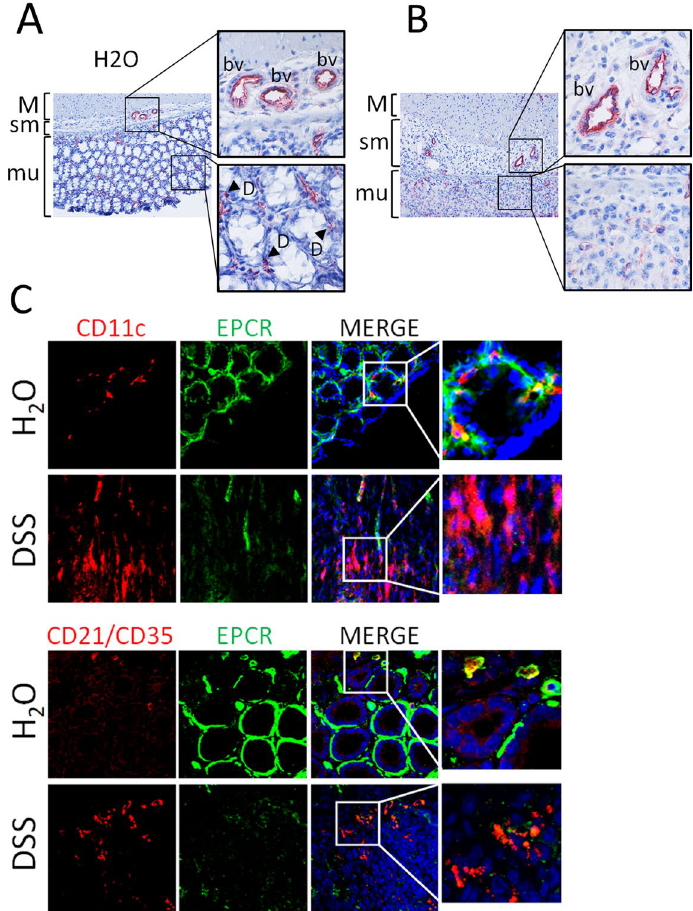
water containing DSS (2.5% w/v) for 10 days. At the end of 10 days, the colon tissues were collected from the mice and processed for immunohistochemistry using goat anti-mouse EPCR antibodies. Tissue sections were imaged at 20X magnification, and boxed areas were digitally magnified ( A ) colon tissue section from control mice; ( B ) colon tissue section from DSS-treated mice. Red staining indicates EPCR positivity. M, muscularis externa; sm, submucosa; mu, mucosa; bv, blood vessels, L, Leukocytes. Arrows in panel A point out leukocytes. ( C ) The colon tissue sections were immunostained for EPCR (green), CD11c (red), or CD21/35 (red). Nuclei were stained with DAPI (blue). Boxed areas were digitally enlarged. Yellow color in merged images indicates the colocalization of EPCR with CD11c or